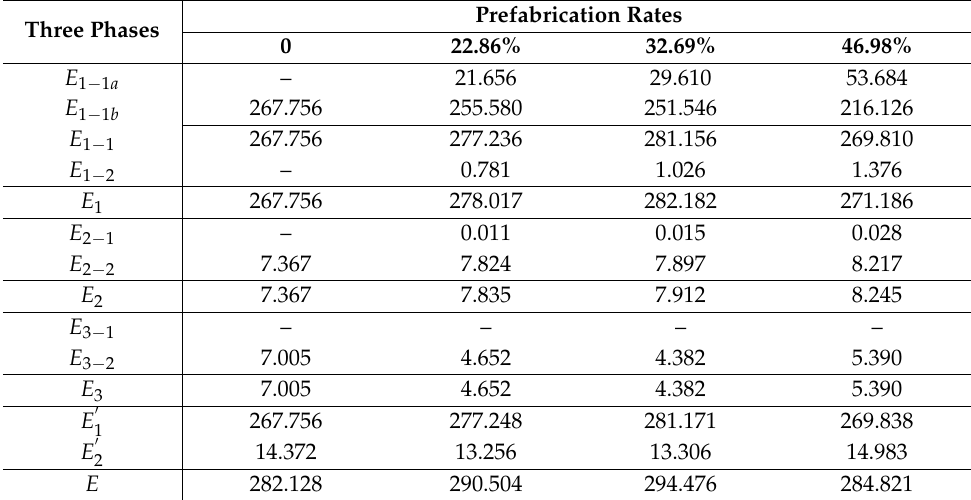
Table 5. The Carbon Emission Results of the Case Building under Different Prefabrication Rates (Unit: kgCO 2 /m 2